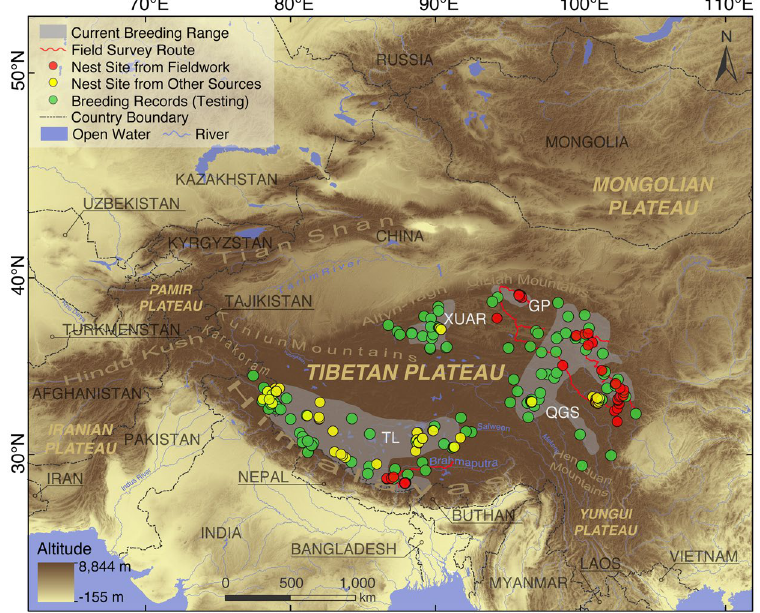
Figure 1. Study area, current breeding range, species distribution data, and field survey route. Presented on the digital elevation map (DEM) for displaying geographic conditions; the current breeding range was digitized by the author from Dorn Moore, International Crane Foundation (Li 9 ). Detailed information for nest sites and breeding records is shown in Table 1. Field survey route (mega-transect) was recorded with a global positioning system (GPS) logger in real time. The map was made by the authors in ArcGIS 10.1 (ERSI co., USA) and processed in Adobe Illustrator CC (Adobe Systems Inc., USA).